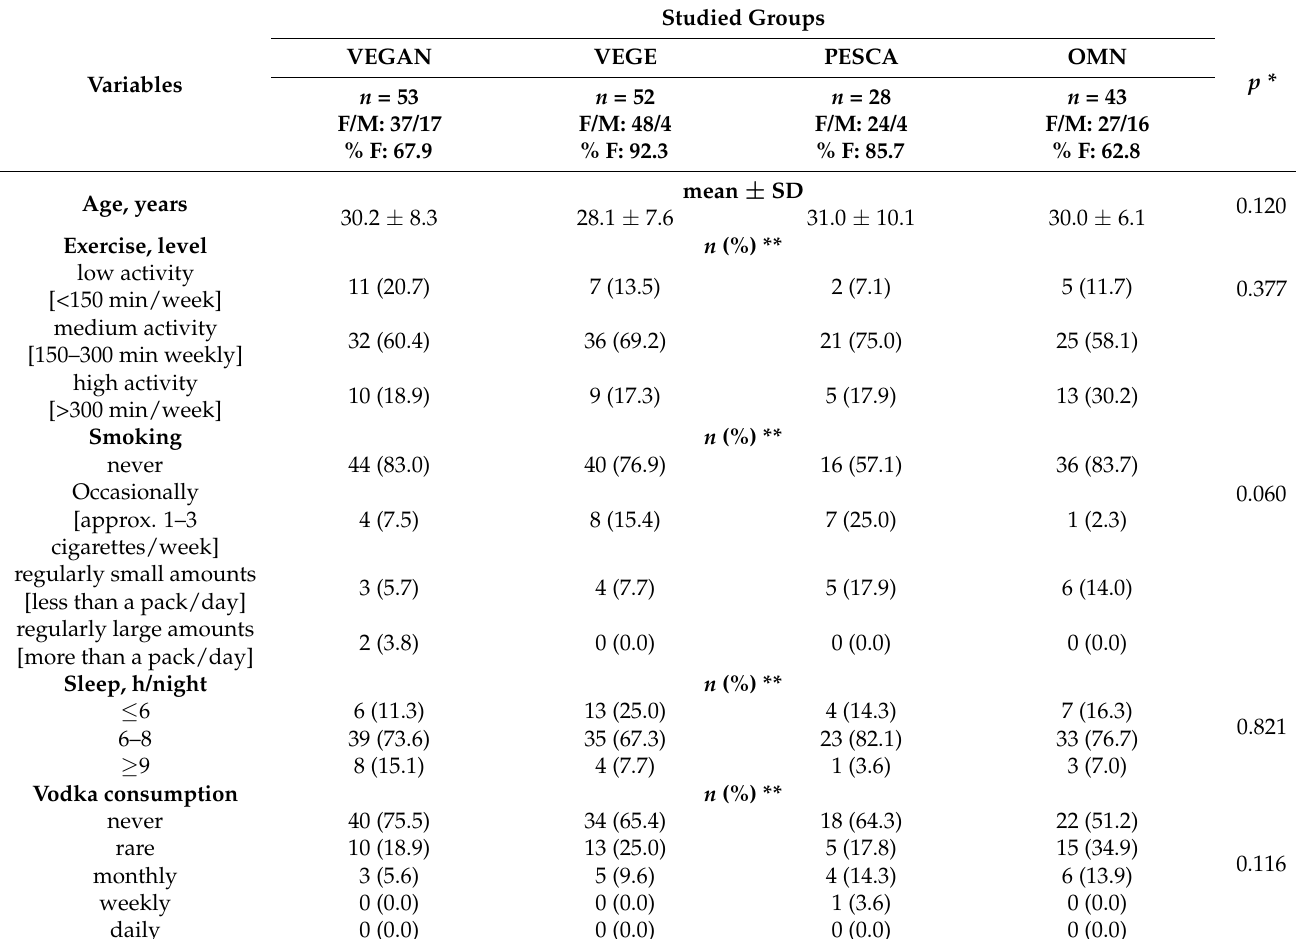
Table 3. Baseline characteristics of the